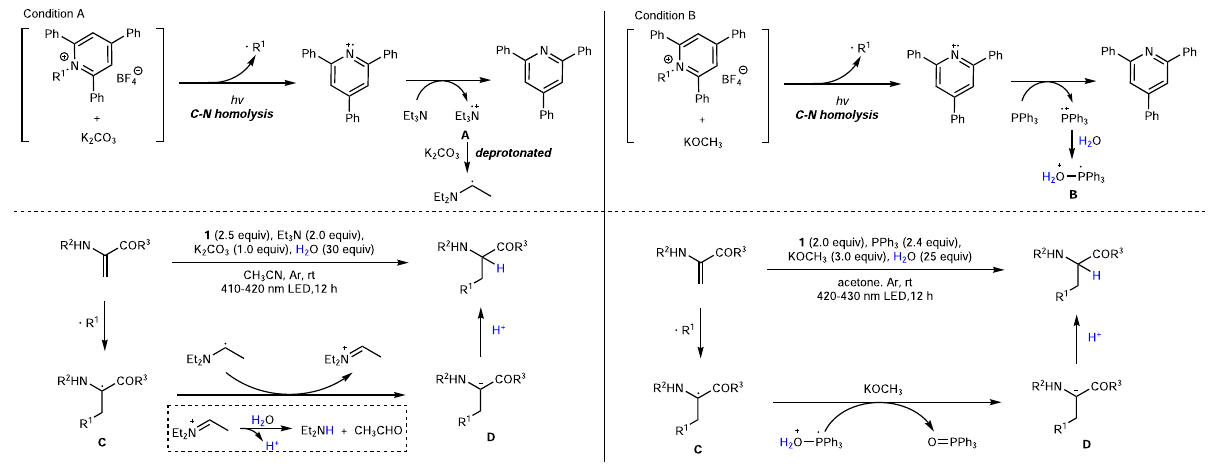
Fig. 5 Proposed mechanism. Visible-light-mediated catalyst-free synthesis of unnatural α